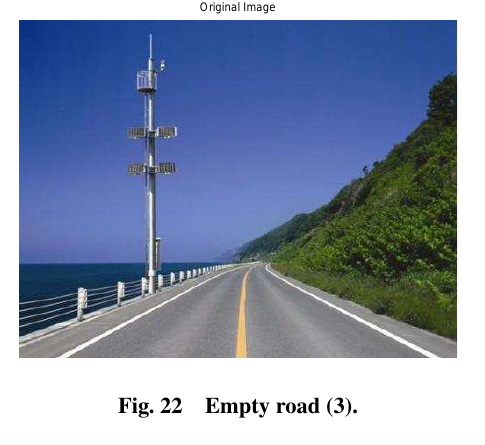
Fig. 24 Horizontal axis’ brightness values and search result (with grate filter) according to Fig. 22.